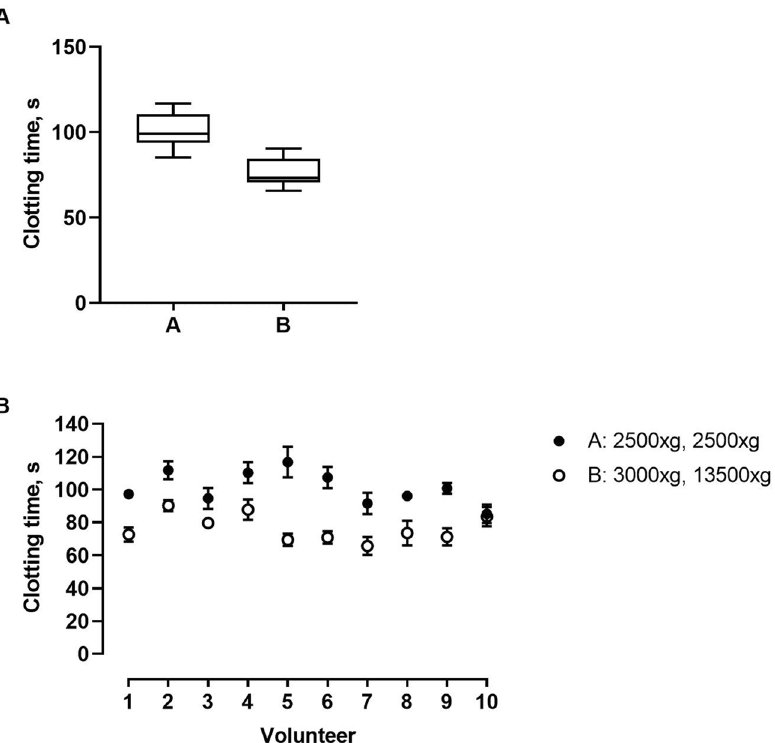
Figure 4. The effect of platelet free plasma (PFP) preparation on clotting time. PFP from 10 volunteers were prepared using two different centrifugation protocols, ( A ) 2500×g for 15 min twice or (B) 3000× g for 10 min followed by 13,500× g . Clotting times were measured using the modified PPL assay. Panel ( A ) is a box plot of all ten volunteers combined for the two protocols, while panel ( B ) displays the individual values as mean of duplicate measures ± 1 SD.